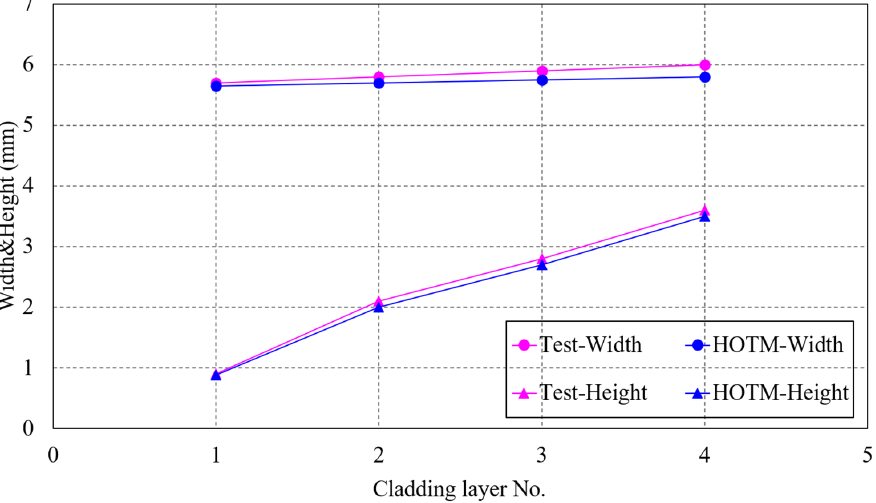
Figure 15. The width and height of the cladding layer of the HOTM simulation and the experiment.